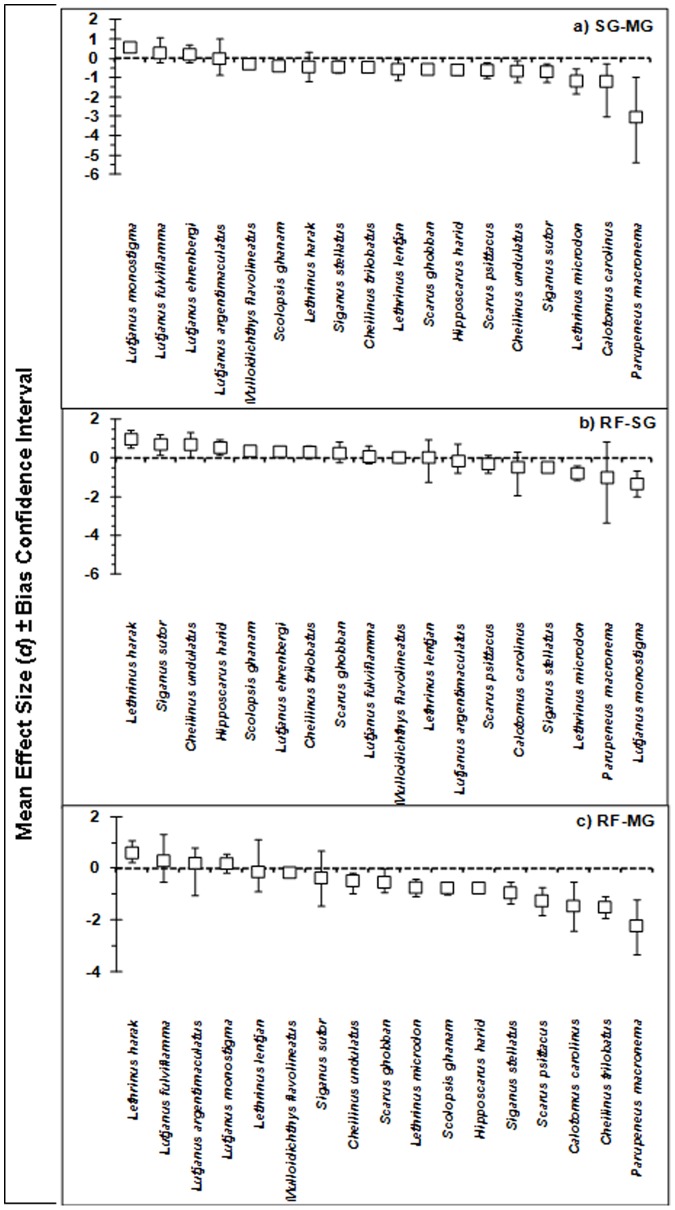
Rank-order of species-specific habitat utilization patterns based on the weighted mean effect size (d+) ± bias-corrected 95% confidence interval (based on variability across study locations) for the Indo-Pacific region for a) seagrass (SG) – mangrove (MG) comparison, b) coral reef (RF) – seagrass comparison, and c) coral reef – mangrove comparison.If confidence intervals do not cross the vertical line at d = 0, the effect size is significant.